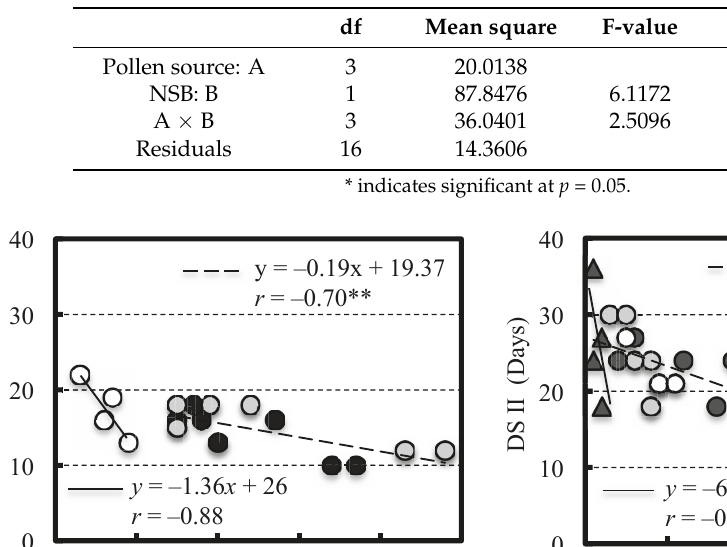
Table 8. Results of ANCOVA determining the parallelism of the regression lines between NSB and DS II among pollen sources in the 2015 experiment.